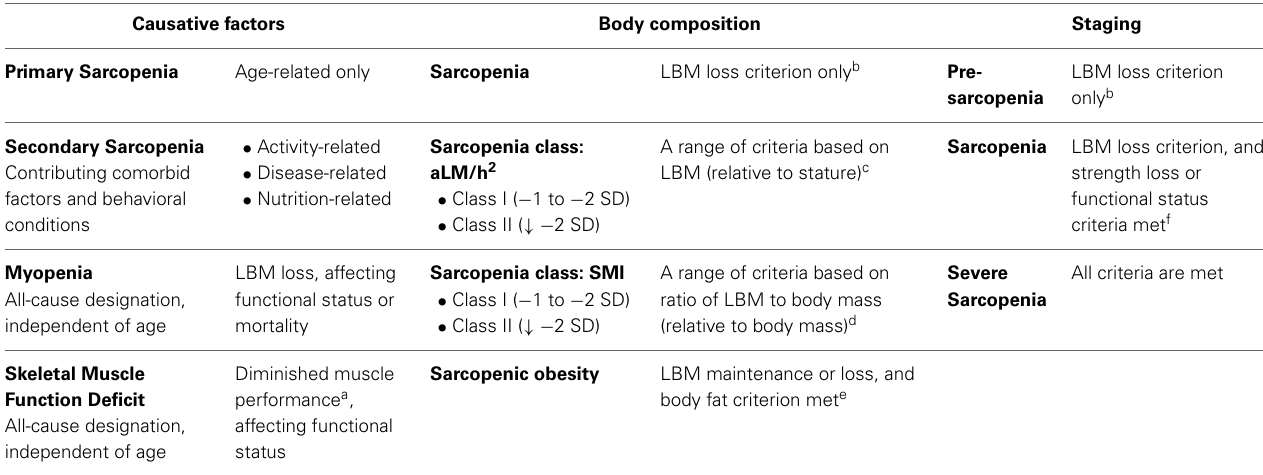
Table 1 | Categories of the sarcopenia syndrome based on causative factors, body composition, and stages of